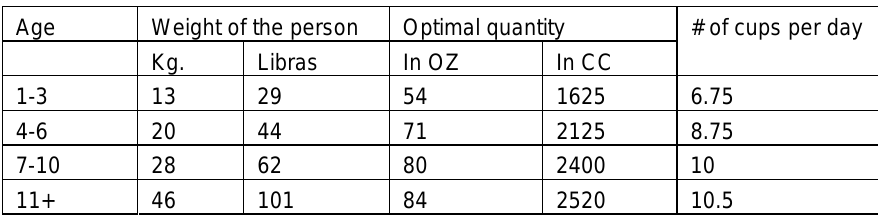
Recommended Water Requirements per Age and